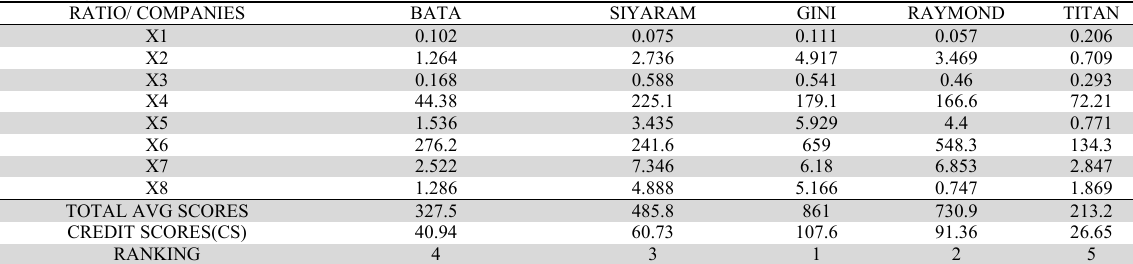
Ranking on the basis of Credit Scores of the Selected Companies of Retail Sector RATIO/ COMPANIES